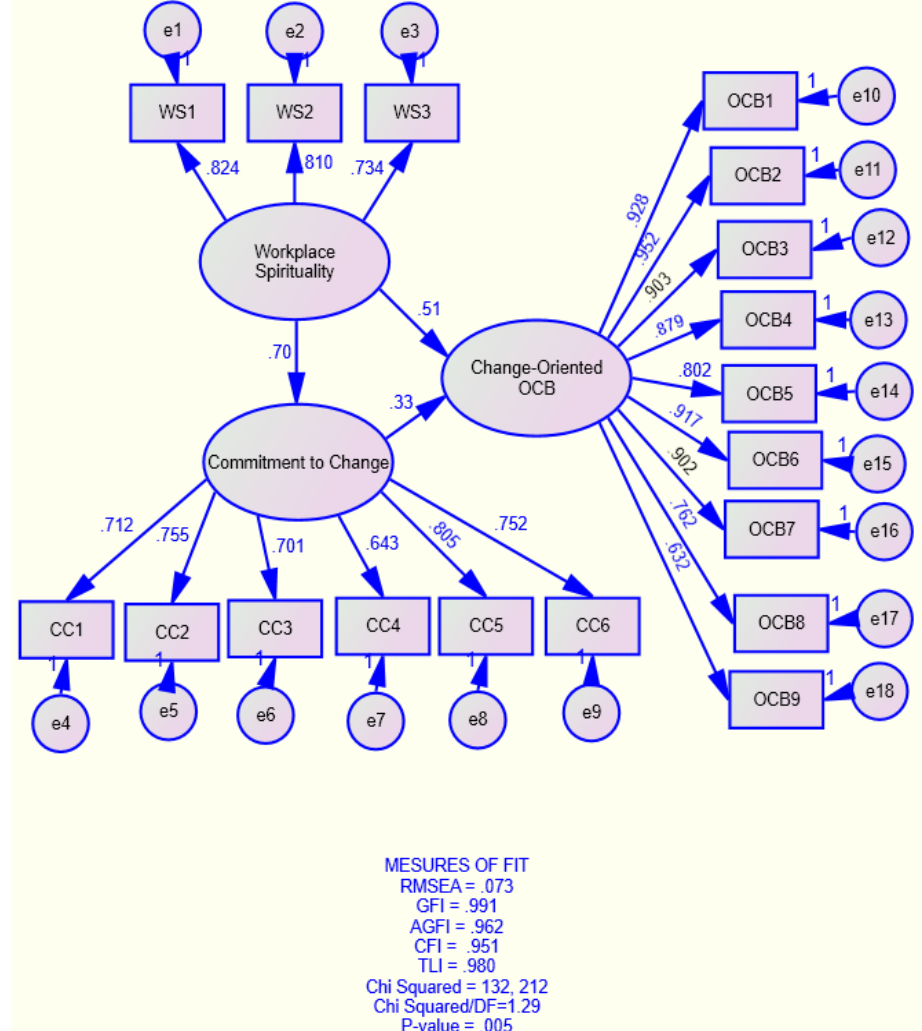
Figure 2. Results of the SEM analysis of the conceptual model.